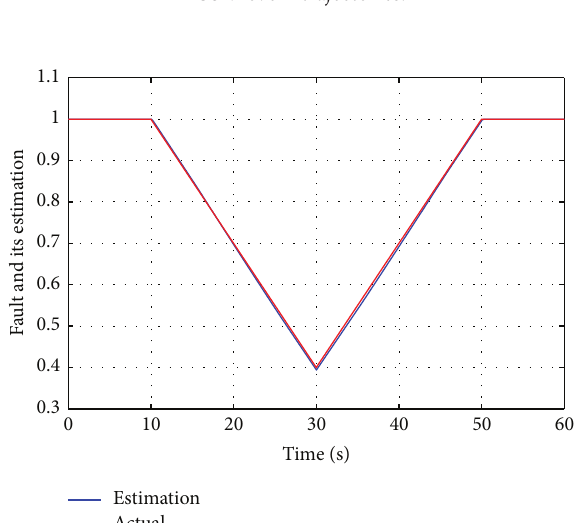
Figure 3: 3D trajectories.